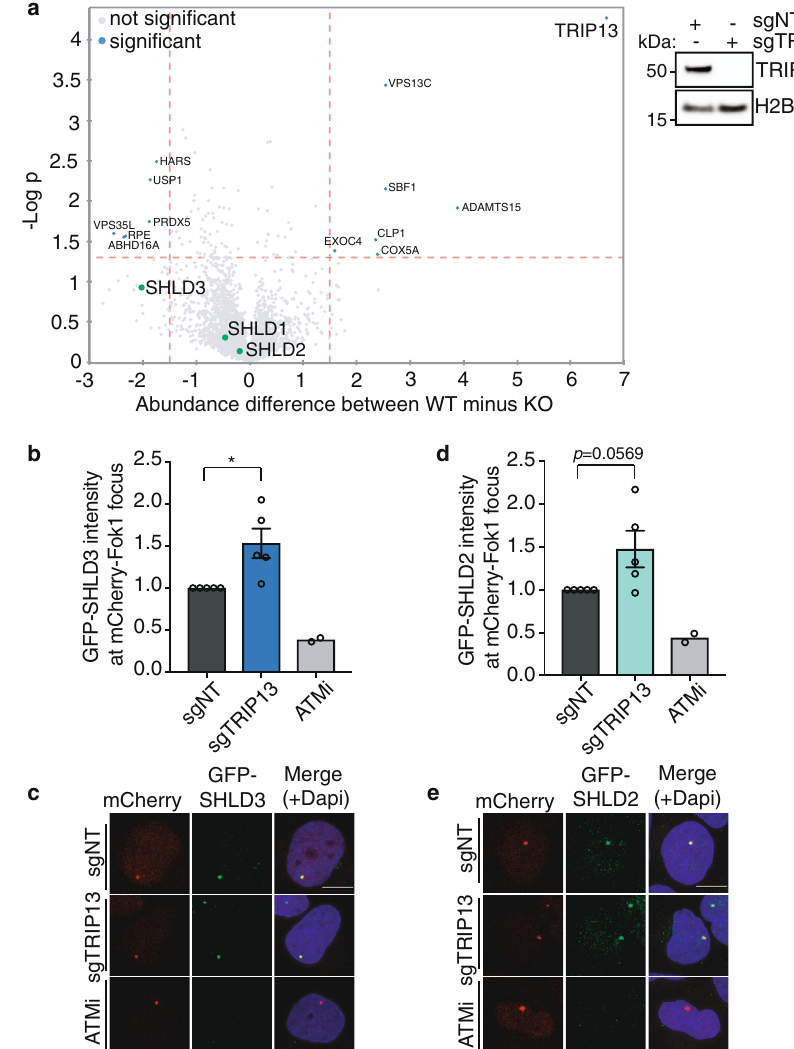
Fig. 6 TRIP13 controls the assembly of SHLD2/3 at DNA breaks. a Left: Mass-Spectrometry analysis of MAD2L2 interactions upon pulldown of 3x fl ag- tagged MAD2L2 in 293T cells transduced with sgNT or sgTRIP13. Vulcanoplot represents the abundance difference between the sgNT (WT) and sgTRIP13 (KO) cells and signi fi cance over n = 3 independent pulldown experiments. Right: Immunoblot of 293T cells used for mass-spectrometry analysis. b Quanti fi cation of the intensity of GFP-tagged SHLD3 signal at mCherry-LakI-Fok1 foci 3 h post activation of the Fok1 nuclease by addition of 4-OHT and shield-1. Graph represent the mean ± s.e.m. of n = 5 (except for ATMi-treated conditions for which n = 2) relative to the sgNT transduced cells. A minimum of 129 cells were analyzed per condition per experiment. Signi fi cance was calculated using an unpaired two-tailed t -test, * p = 0.0168. c Representative image of cells quanti fi ed in b . d Quanti fi cation of the intensity of GFP-tagged SHLD2 as in b . A minimum of 88 cells were analyzed per condition per experiment (two-tailed unpaired t -test, ns p = 0.0569). e Representative image of cells quanti fi ed in d . Scale bar, 10 μ m. Signi fi cance; ns, not signi fi cant ( p ≥ 0.05), *p < 0.05. Source data are provided as a Source Data fi